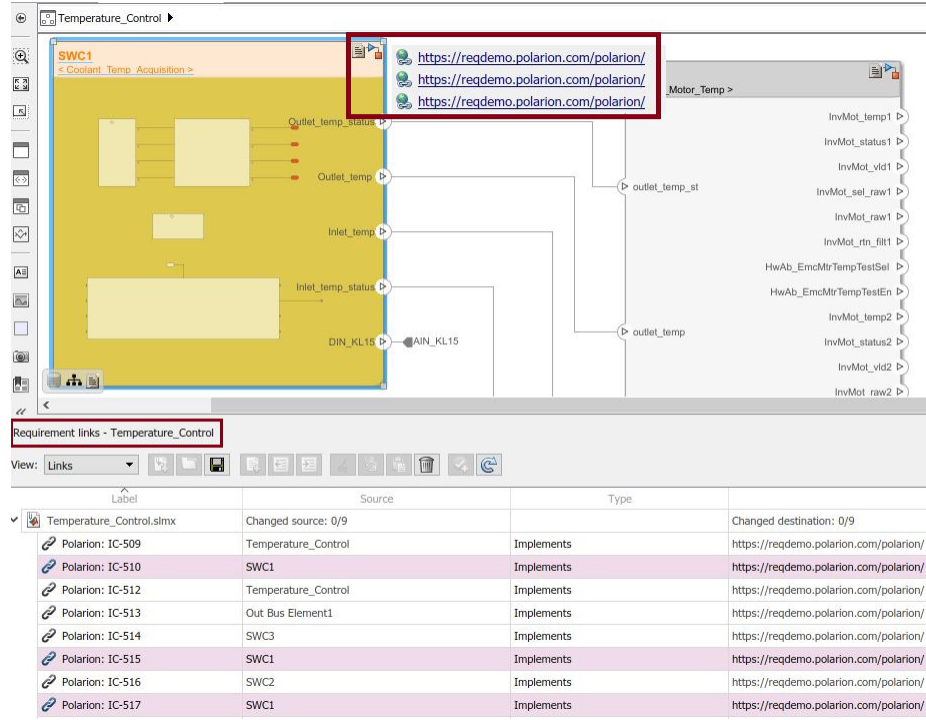
Figure 9. Requirements traceability-requirements database has navigable link to track all the require- ments driving the corresponding architectural block in the model. Additionally, the block lists all the requirements corresponding to a software component (SWC1) and from modeling environment, we can track back to requirements